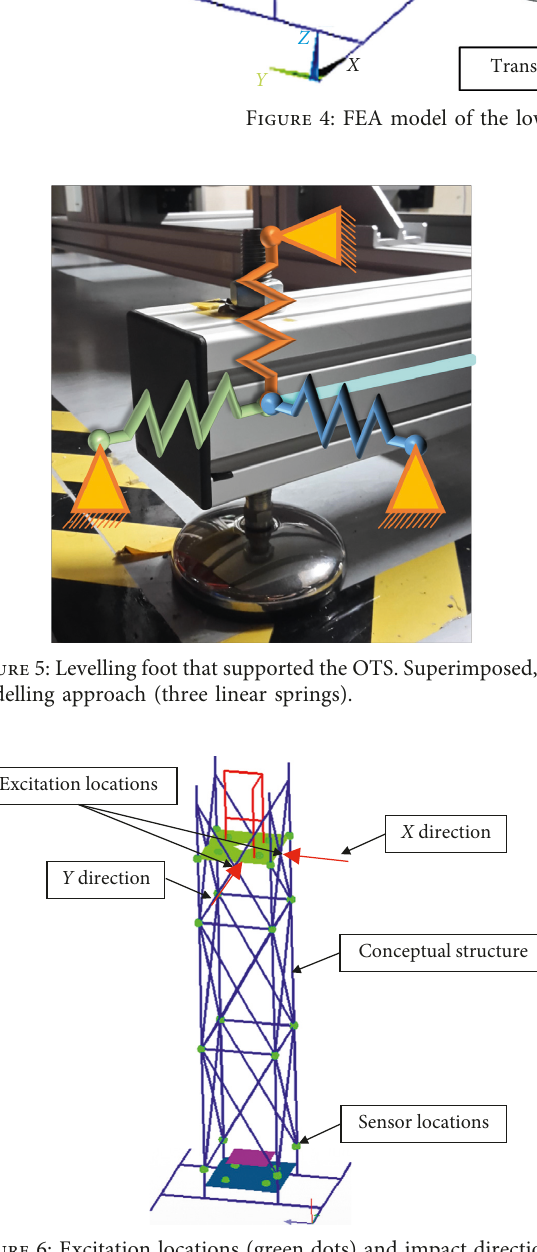
Figure 6: Excitation locations (green dots) and impact directions (red arrows) on the LMS Test.Lab geometry definition.